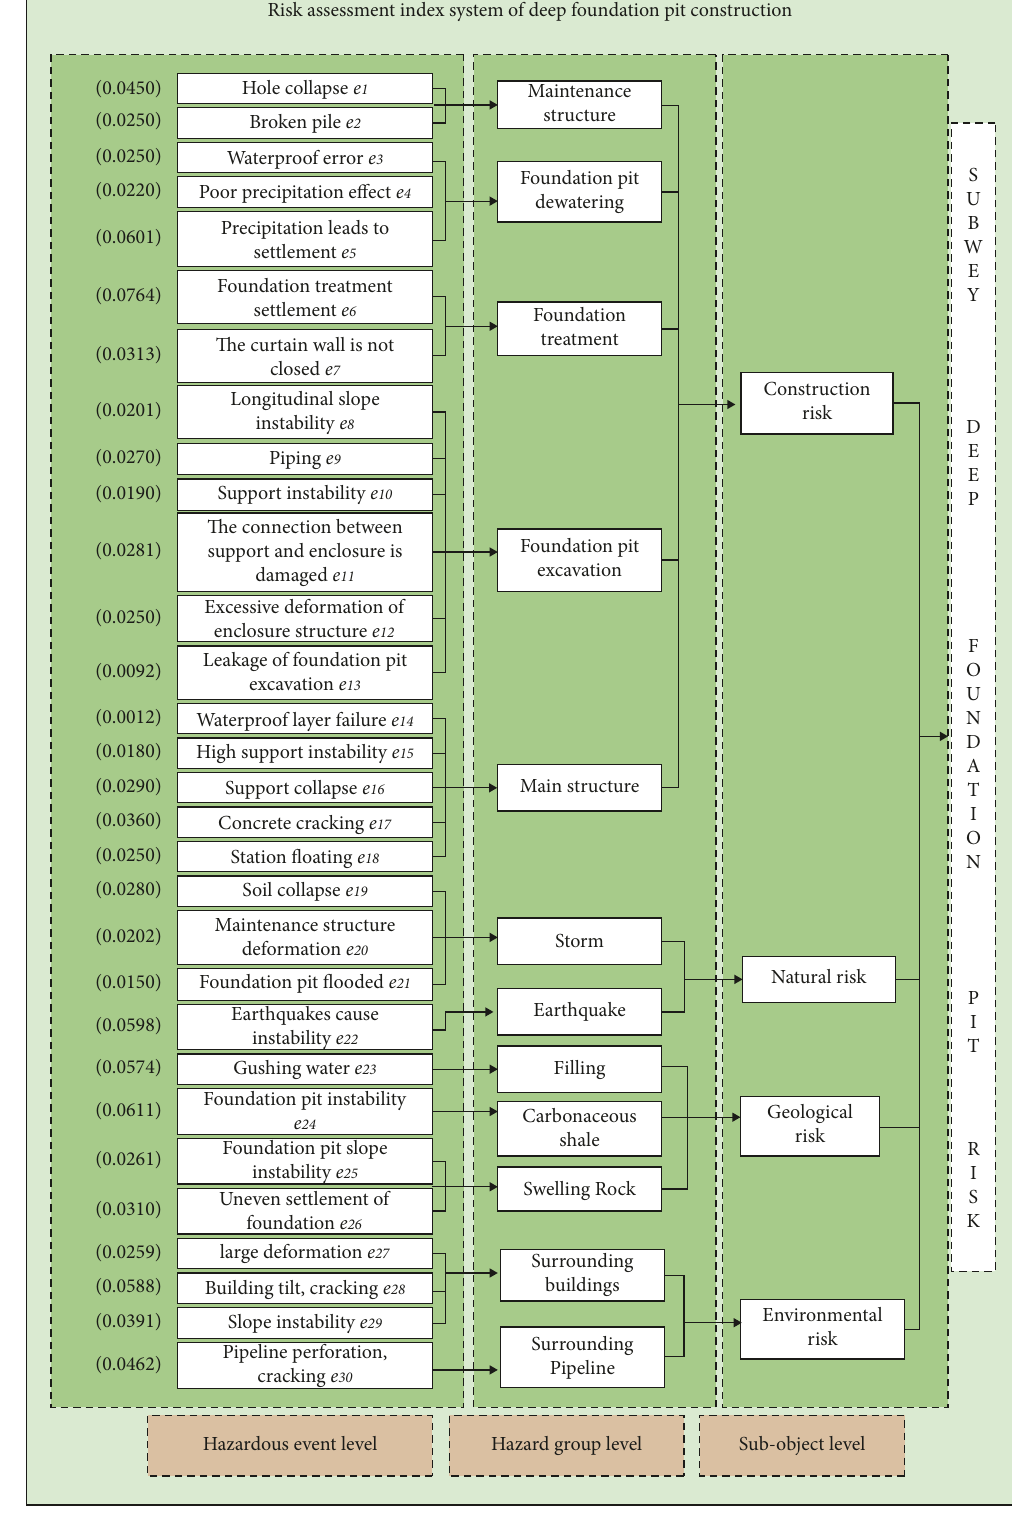
Figure 6: Risk system of DFP